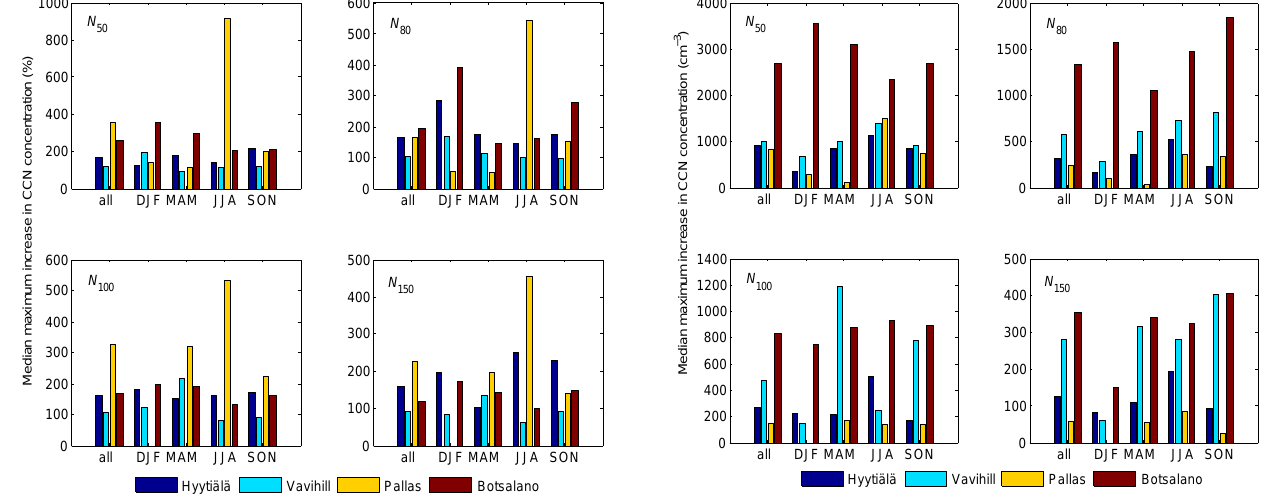
Fig. 5. Median maximum increase in four examined CCN concen- trations expressed in percent as a result of nucleation at four loca- tions. The results are shown separately for all events and for differ- ent seasons.